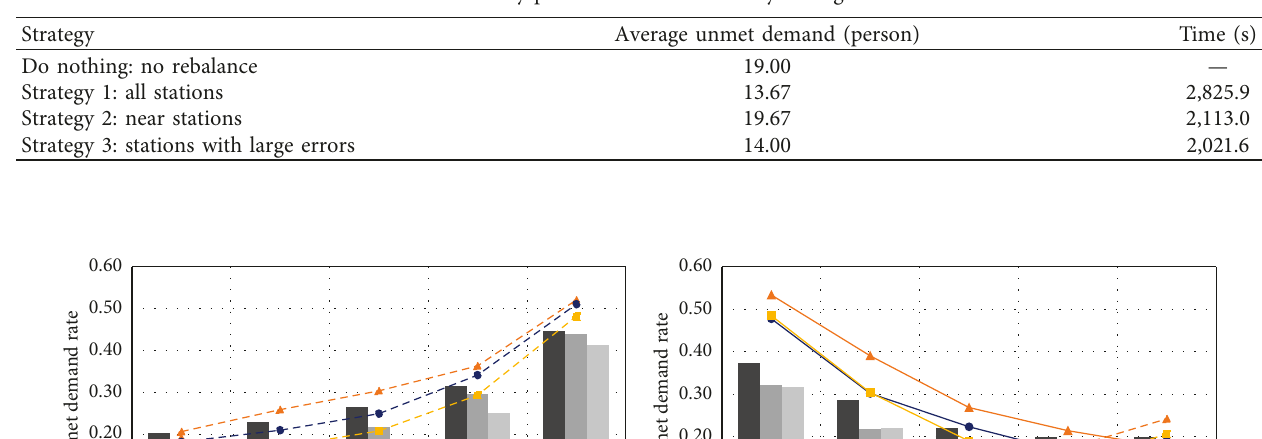
Table 3: Key performance indicators by